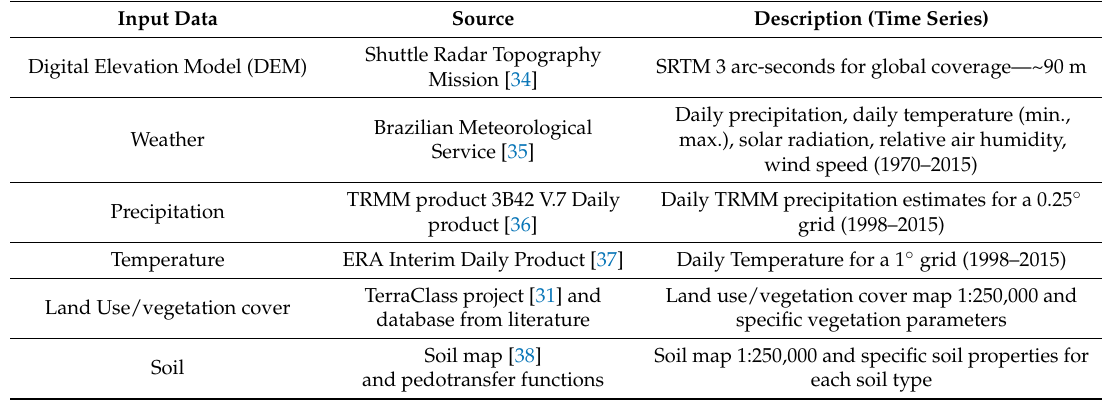
Table 1. Main model input